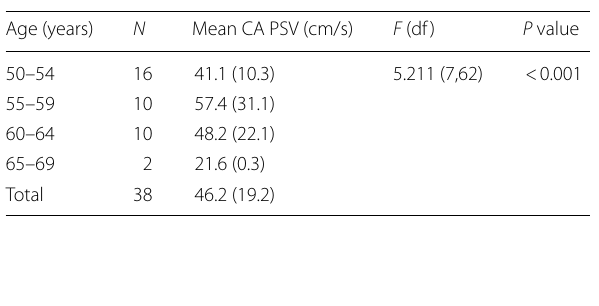
Table 5 Frequency distribution of the patients based